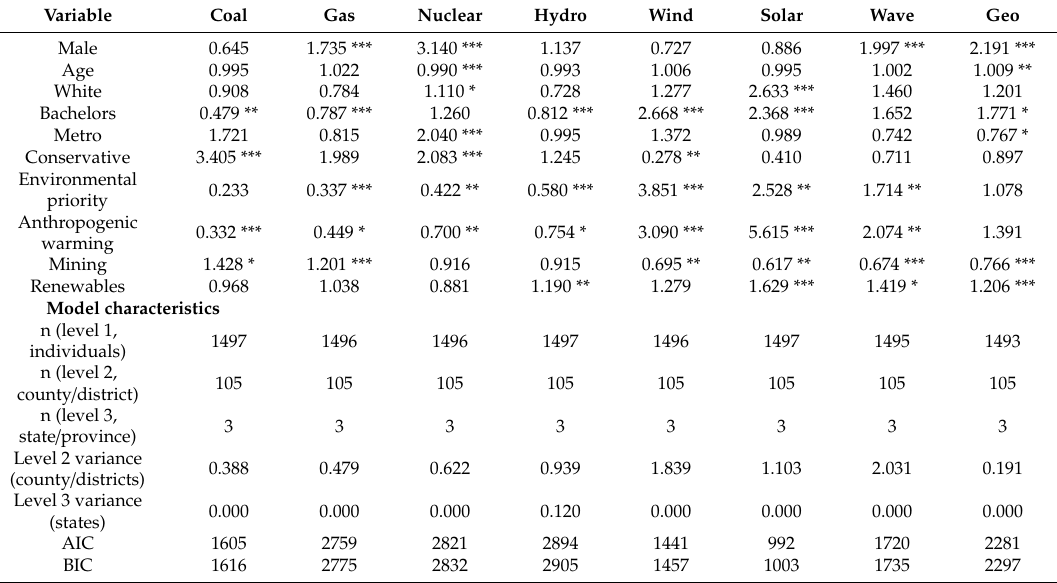
Table 2. Weighted ordered logistic multilevel regression models predicting support for the eight energy